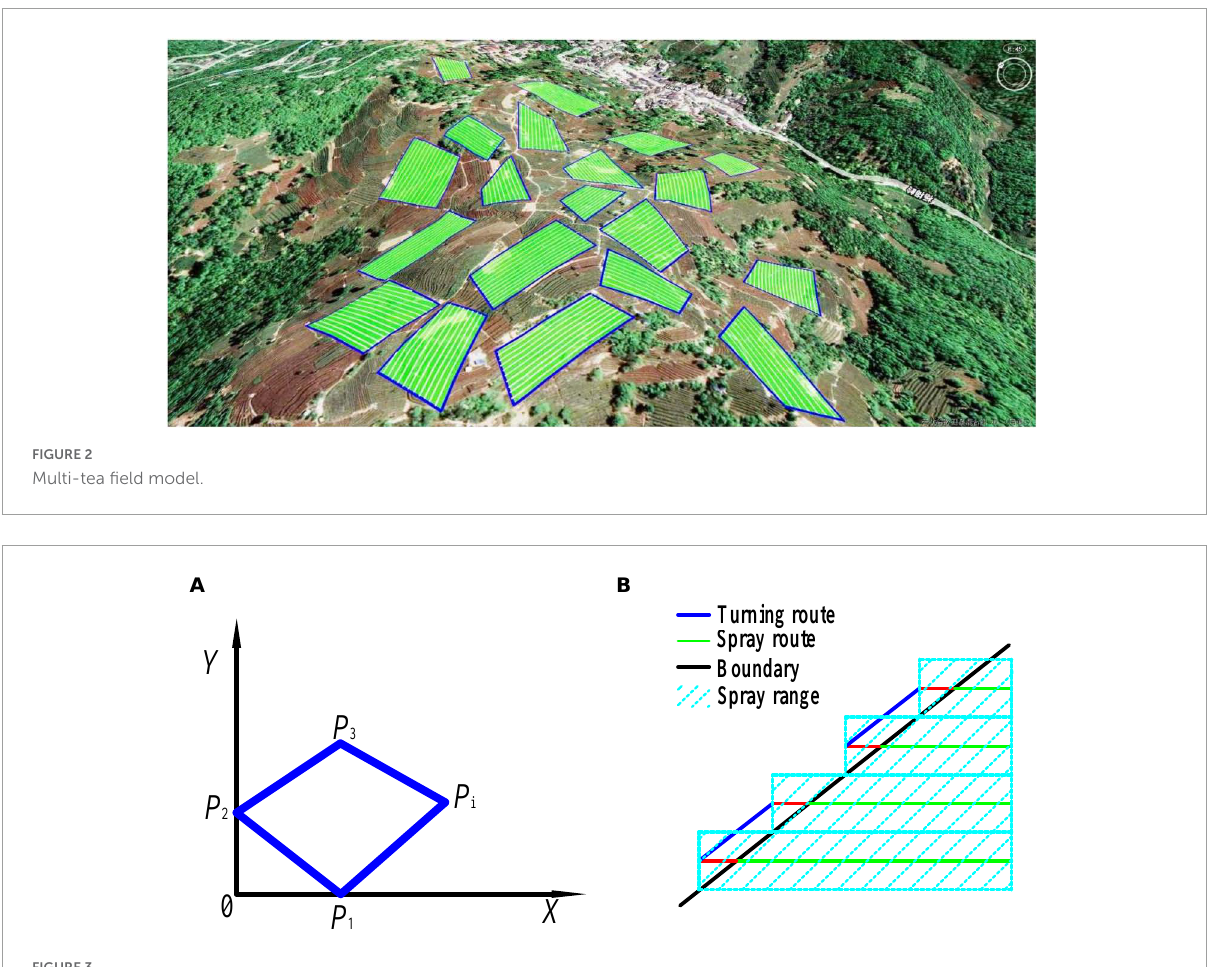
FIGURE3 A diagram of the spraying area and the spraying route in the border area of the single tea field. (A) Spray area; (B) the route to the border of the tea